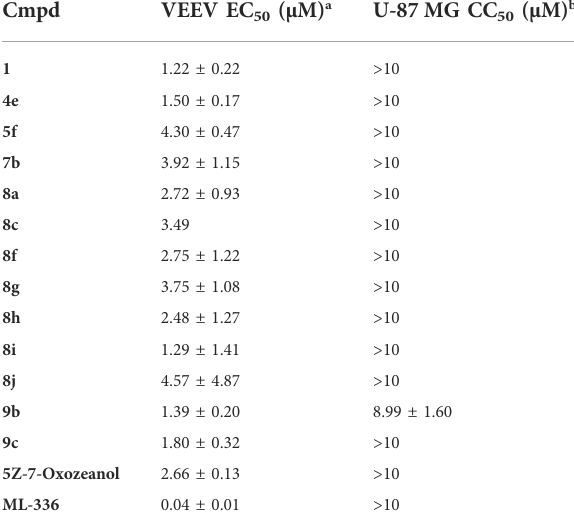
TABLE 9 Anti-VEEV activity and cytotoxicity of selected 5-aryl-3- alkynyl-pyrrolo[2,3- b